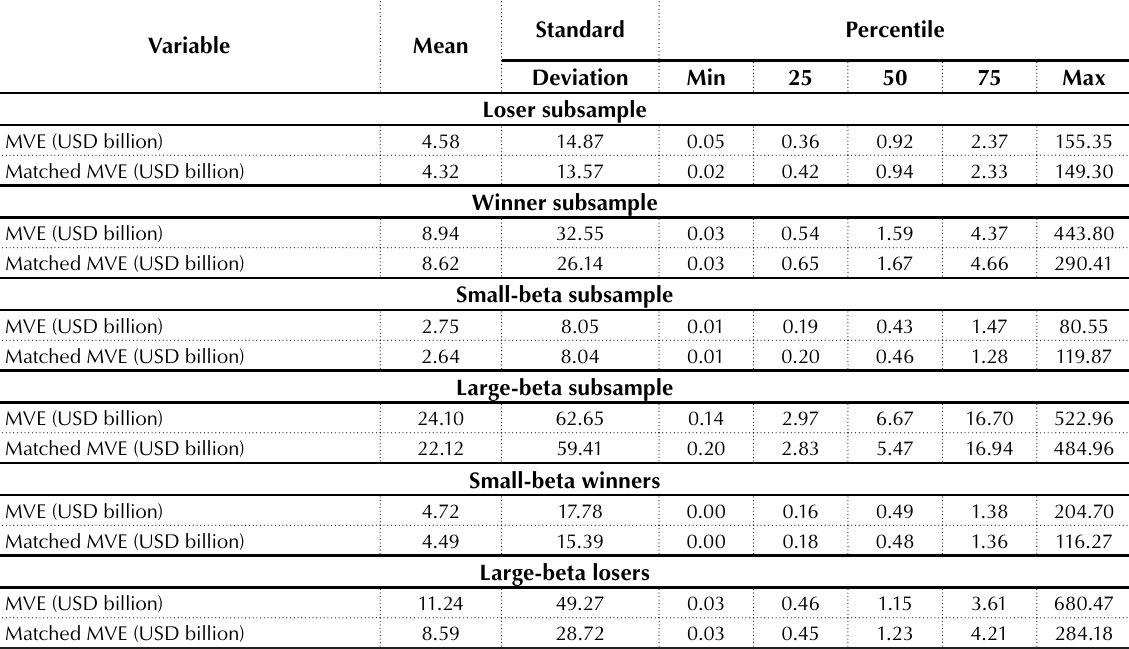
Table 5. Descriptive statistics for matched samples